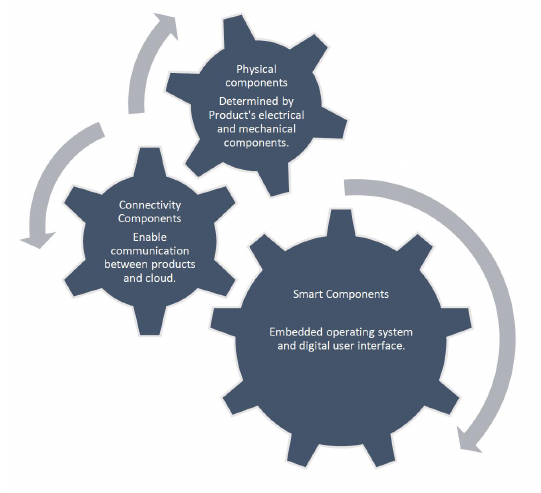
Figure 7. Towards smart processes.